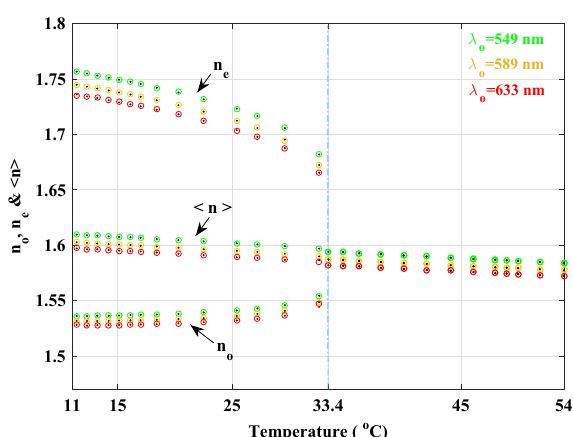
Figure 9. Extraction of n o , n e and < n > = ( n e + 2 n o )/ 3 in the two nematic and isotropic phases using Eq. (14) for three wavelengths to fit on experimentally measured visibility curves obtained from sample 5CB. We have merged the experimental data (black dots) and the calculations from Eq. (14) (colored circles) into one graph in order to compare their high degree of